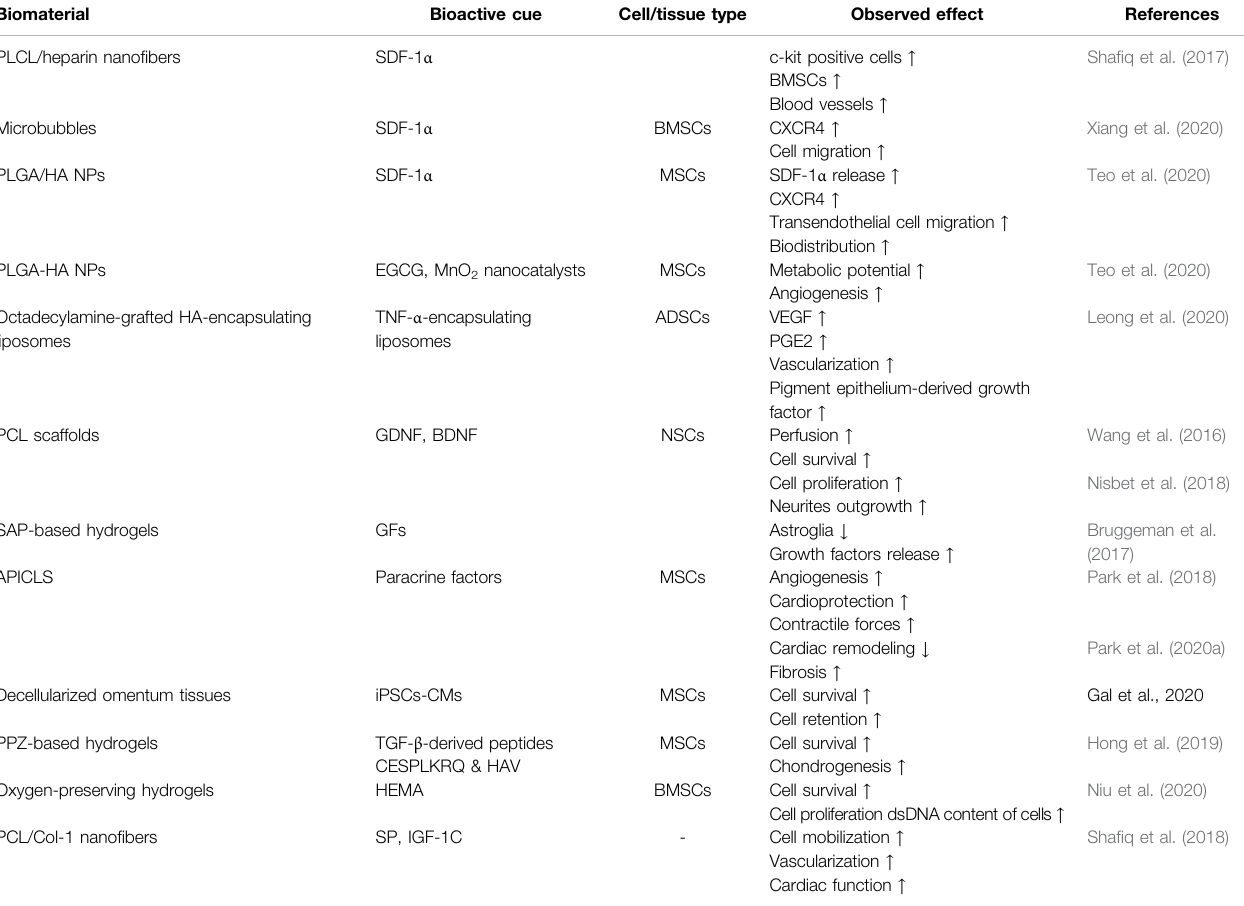
TABLE 4 | Enhancing stem cell retention using instructive